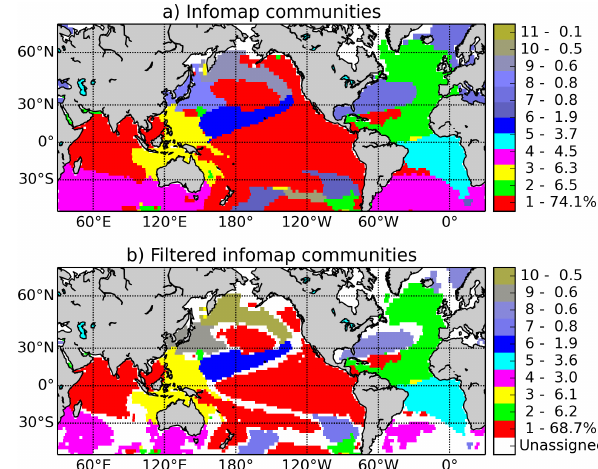
Fig. 2. (a) Infomap communities in the H-SST network. Each color Fig. 2: Top panel (a): Infomap communities in the H-SST network. Each color represents one represents one community and each node is assigned the color of the community and each node is assigned the color of the community it belongs to. The communities community it belongs to. The communities are ordered by decreas- are ordered by decreasing total PageRank of their nodes which is written to the right of the scale. ing total PageRank of their nodes, which is written to the right of the scale. (b) Infomap communities after filtration of nodes that are Bottom panel (b): Infomap communities after filtration of nodes which are connected to a fraction connected to a fraction of their community smaller than twice the of their community smaller than twice the density of the network or belong to communities with density of the network or belong to communities with nodes smaller nodes smaller than 2% of the network. Nodes in white are unassigned, they do not belong to any than 2% of the network. Nodes in white are unassigned, they do not community. belong to any